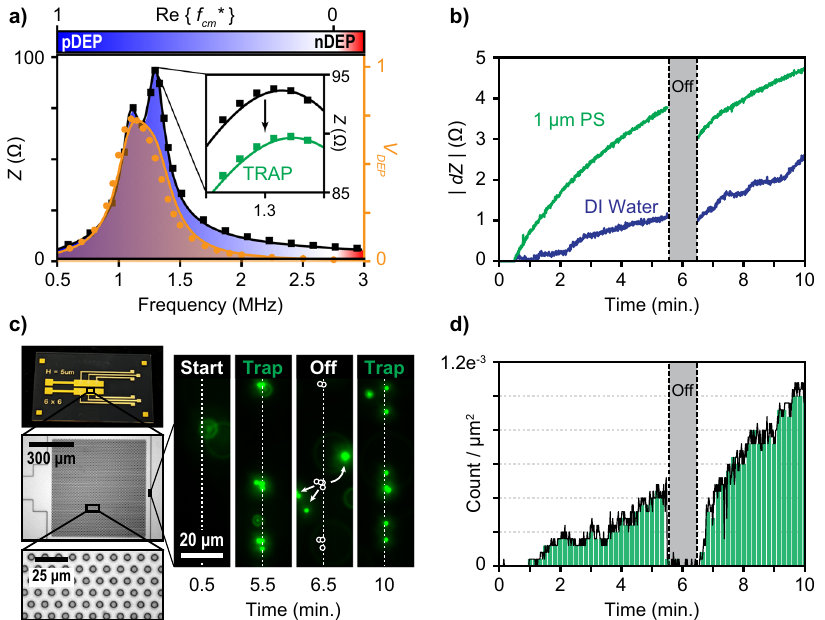
Fig. 6 | Wireless trapping with real-time sensing. a Before particle trapping, the impedance spectrum (black) was measured as a function of frequency with a coil separation of 2.5cm. The regions where pDEP occurs is shaded blue (i.e. fre- quenciesinwhichtherealpartoftheCMFisgreaterthan0).Thevoltageamplitude coupled wirelessly over the microhole DEP device was recorded and peaked at 1.1MHz(orangecurve).Thesetwocurveswere fi tusingnonlinearleastsquareswith ourmeasuredcircuitcomponents.(Inset)Theimpedancespectrumoverafocused regionmeasured in which Z IN wasreduced from94to89 Ω atthetargetfrequency of 1.3MHz after two minutes of particle trapping. b The change in absolute impe- dance was recorded on the transmitting circuit as a function of time for DI water